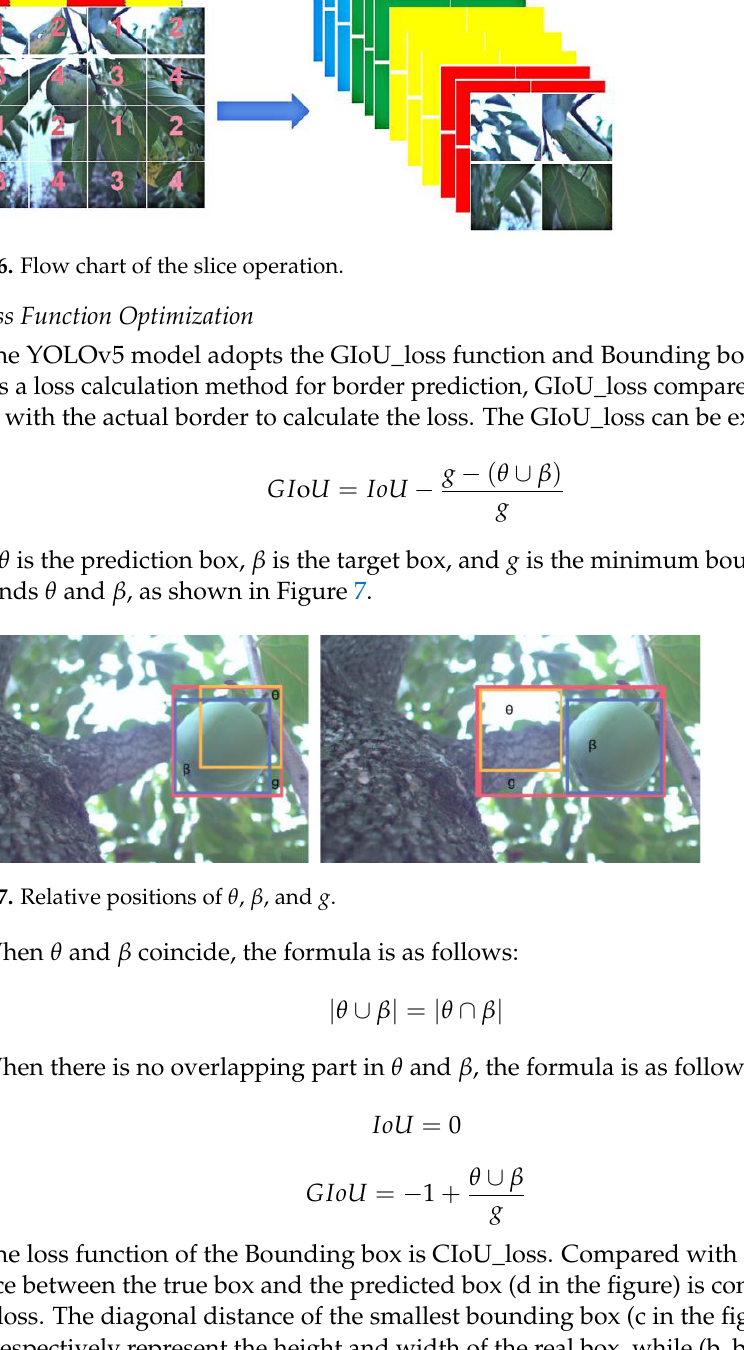
Figure 8. The structure of the CIoU_loss. The CIoU_loss can be expressed as: